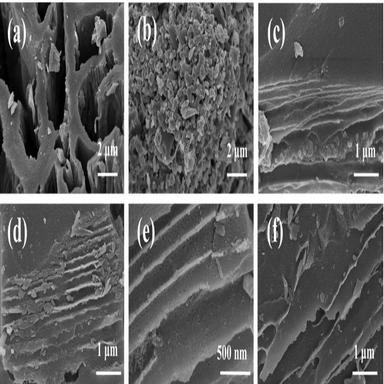
SEM images of the (a) SC-900, (b) LC-900, (c) LEC-800 and (d) LEC-900 samples. High-magnification images of the (e) LEC-900 and (f) LEC-1000 samples.